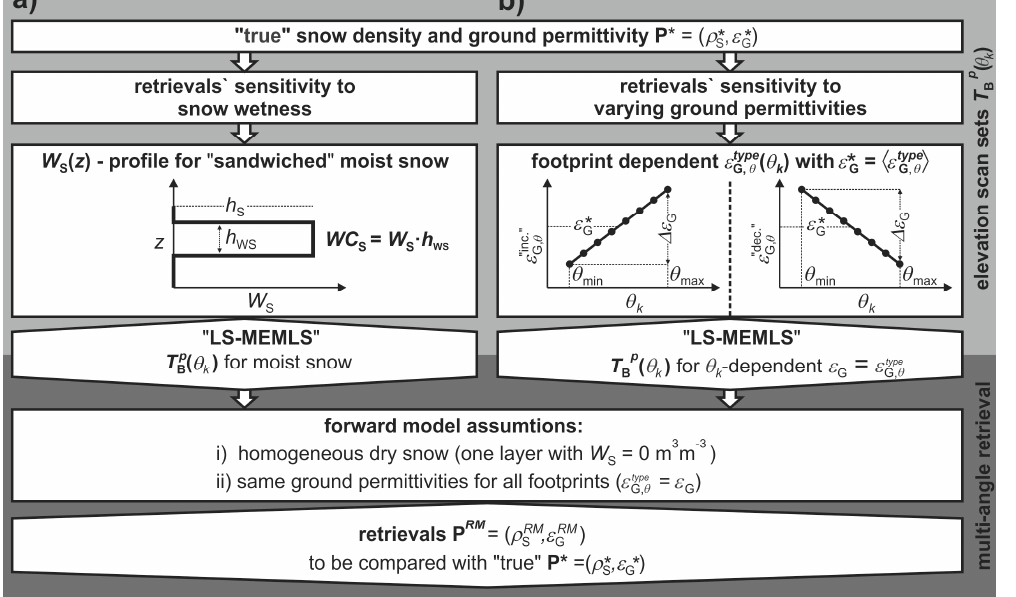
Figure 3. Flowchart of the modeling approach used to infer sensitivities of retrieval pairs (cid:1790) (cid:2174)(cid:2169) = (cid:3435)(cid:2025) (cid:2903)(cid:3019)(cid:3014) , (cid:2013) (cid:2891)(cid:3019)(cid:3014) (cid:3439) to “melting effects” such as: ( a ) snow liquid-water, and ( b ) spatial heterogeneity of ground